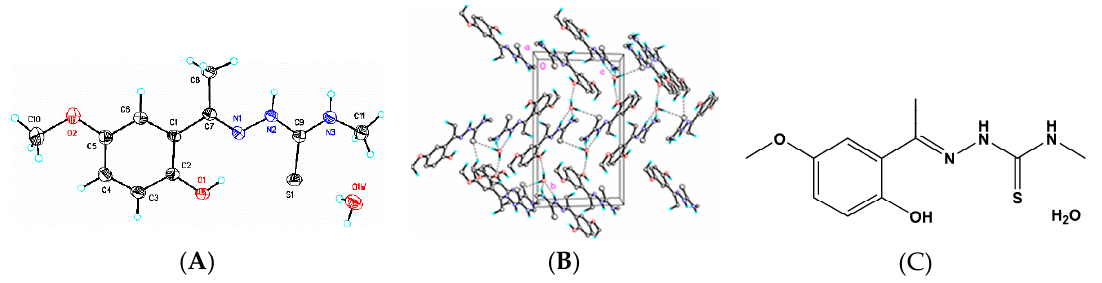
Figure 1. ( A ) ORTEP drawing of ( 1 ) showing the atom numbering scheme and 50% probability displacement ellipsoids of non-H atoms; ( B, C ) The molecular packing of ( 1 ) viewed along the a axis. Dashed lines indicate O–H … N, N–H … O, O–H … O intramolecular hydrogen bonds and weak C–H … S, C–H … O, O–H … S intermolecular interactions forming a 3D supramolecular structure. Hydrogen atoms not involved in hydrogen bonding have been removed for clarity.